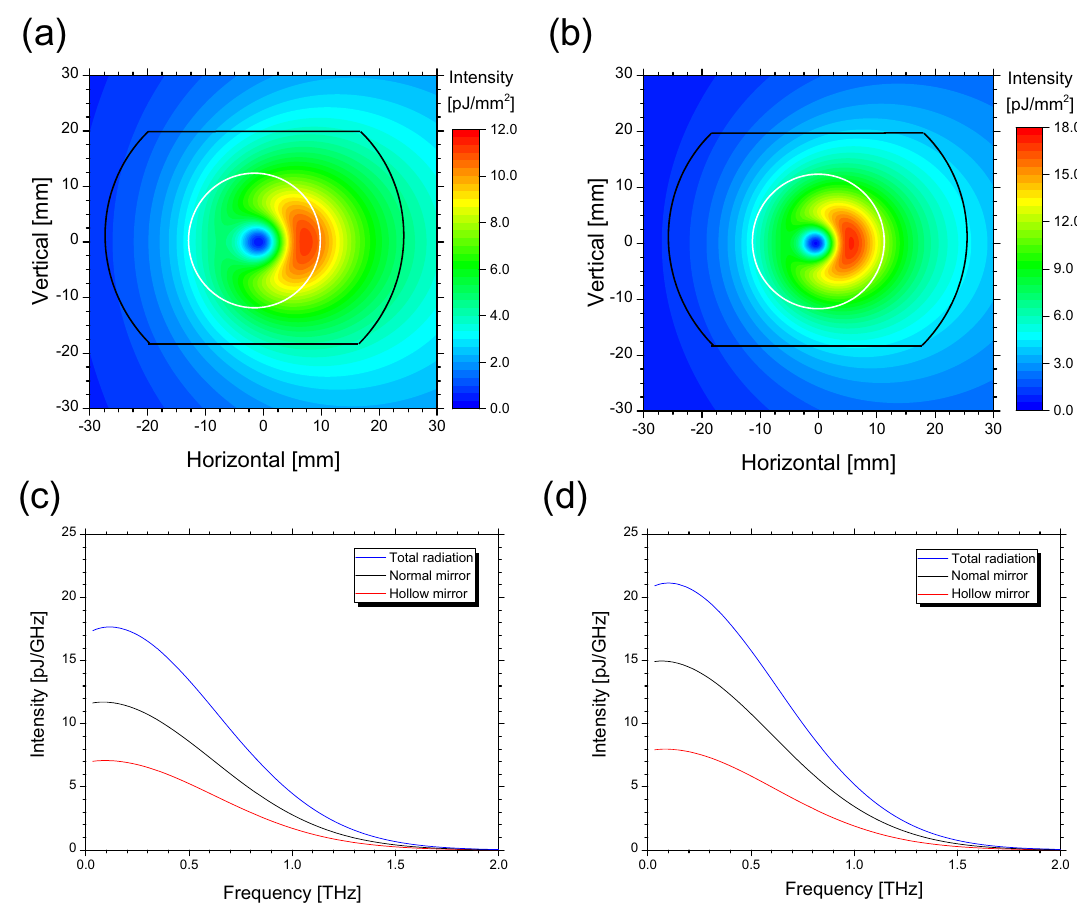
Figure 2. Calculated characteristics of CER beam generated by an electron bunch with a charge of 27.6 pC and an RMS bunch length of 0.06 mm. Spatial distributions of CER beam for electron energies of 58 meV ( a ) and 75 MeV ( b ). White and black solid lines express boundaries of hole of hollow concave mirror and area in which CER is directly irradiated on the mirror surface, respectively. Calculated spectra of CER beam for electron energies of 58 MeV ( c ) and 75 MeV ( d ). Blue, black, and red solid lines are spectra of CER beam irradiated at all solid angles on the normal and hollow concave mirrors,